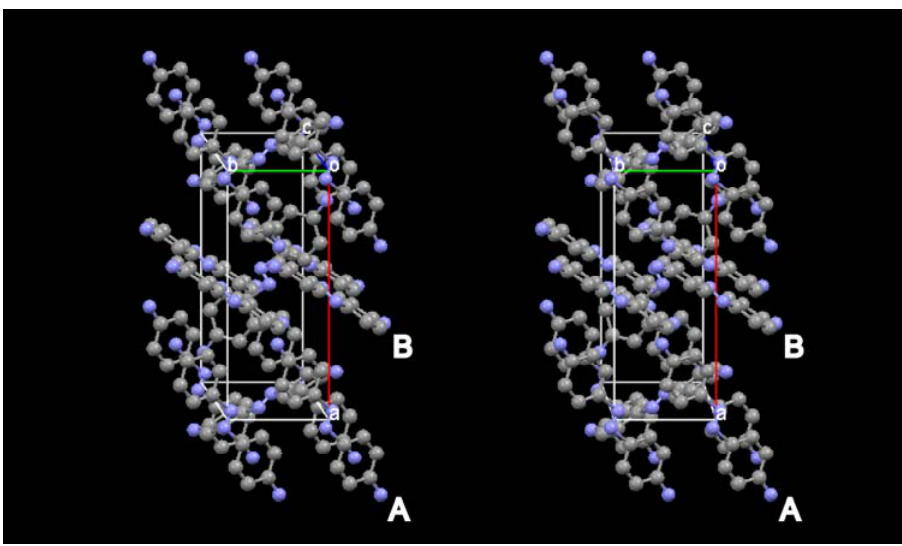
Figure 1. Crystal structure of AAB (stereo